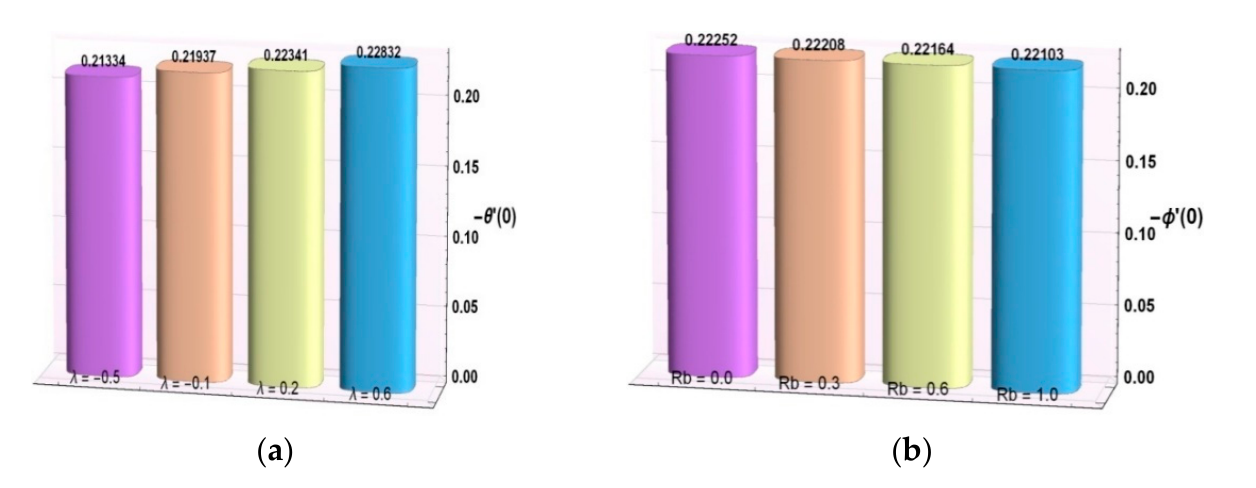
Figure 6. Behavior of ( a ) − θ (cid:48) ( 0 ) for λ and ( b ) − φ (cid:48) ( 0 ) for